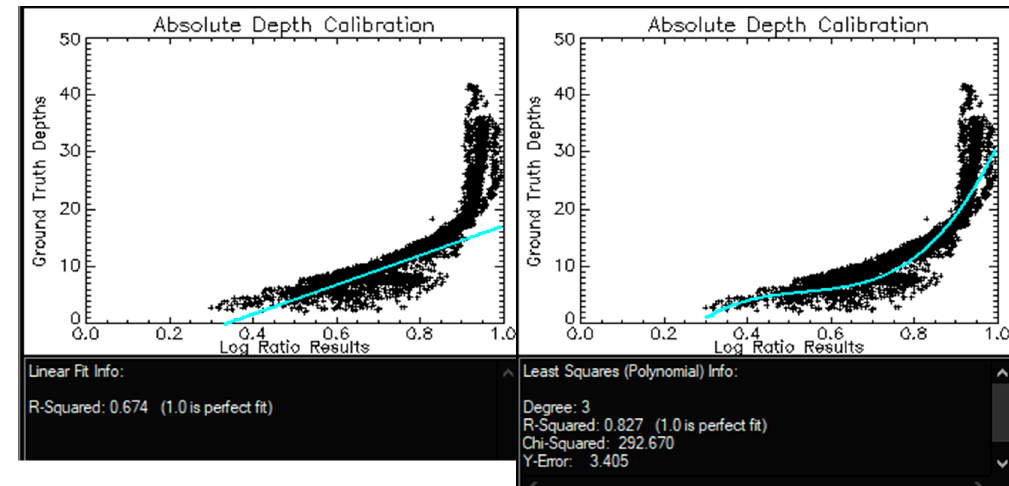
Figure A11. From 1 March 2016.